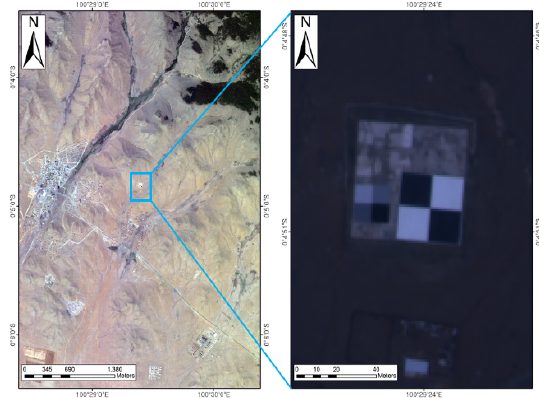
Figure 1. KOMPSAT-3A imagery at the Zuunmod site